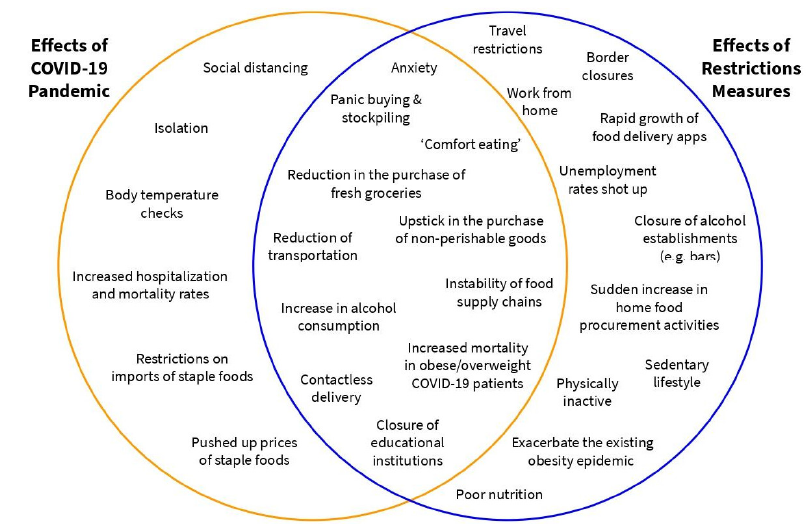
Figure 1. Effects of the COVID-19 Pandemic and Restriction Measures.